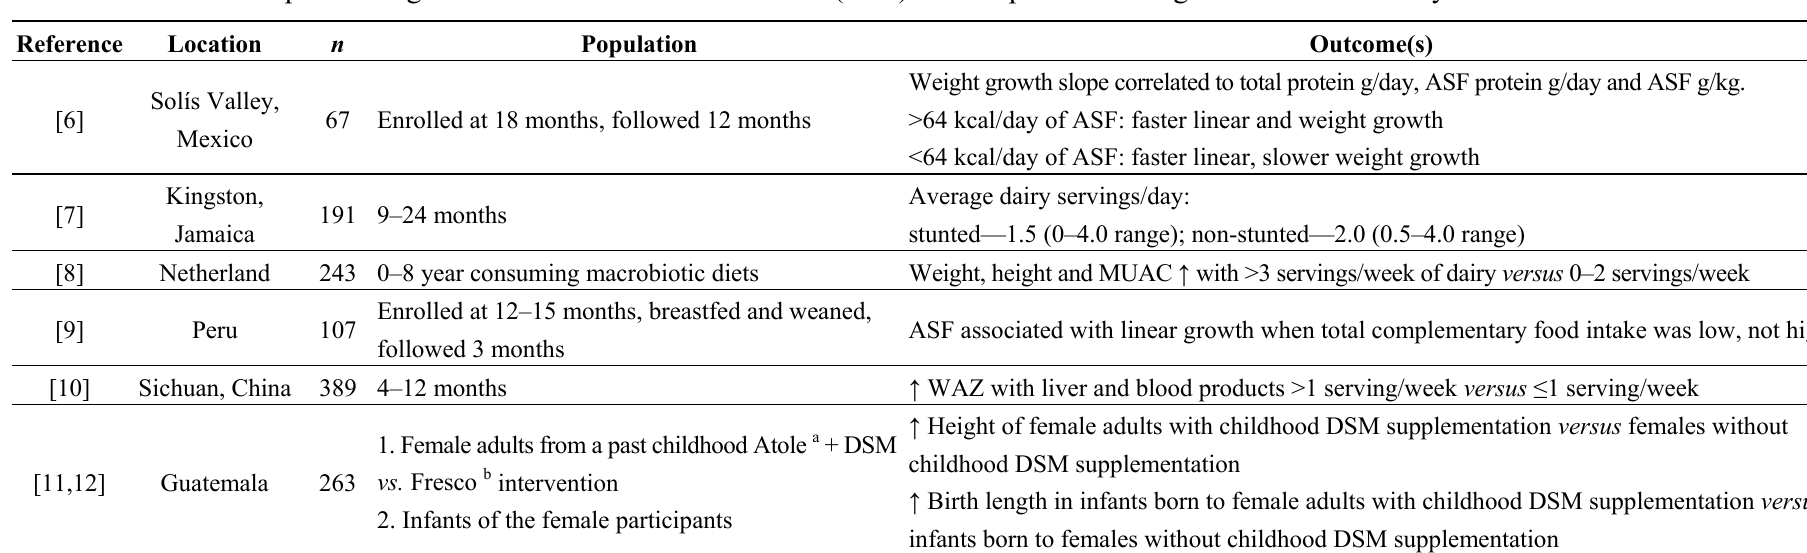
Table 1. Epidemiological studies of animal source food (ASF) consumption and the growth of nutritionally vulnerable children.